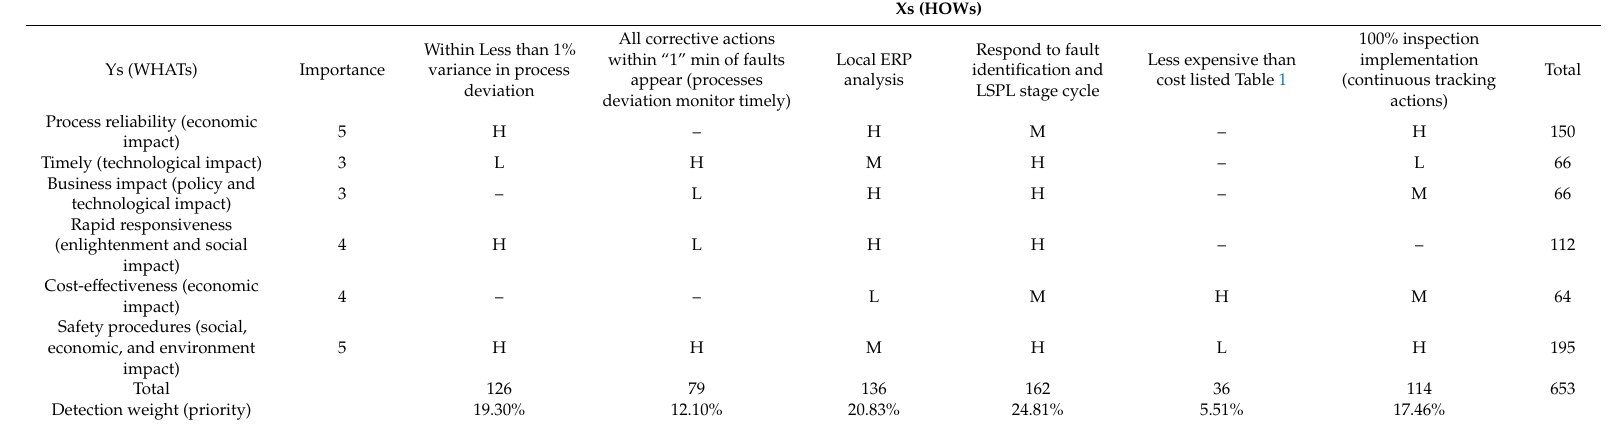
Table 5. Safety Function Deployment (Step 1).